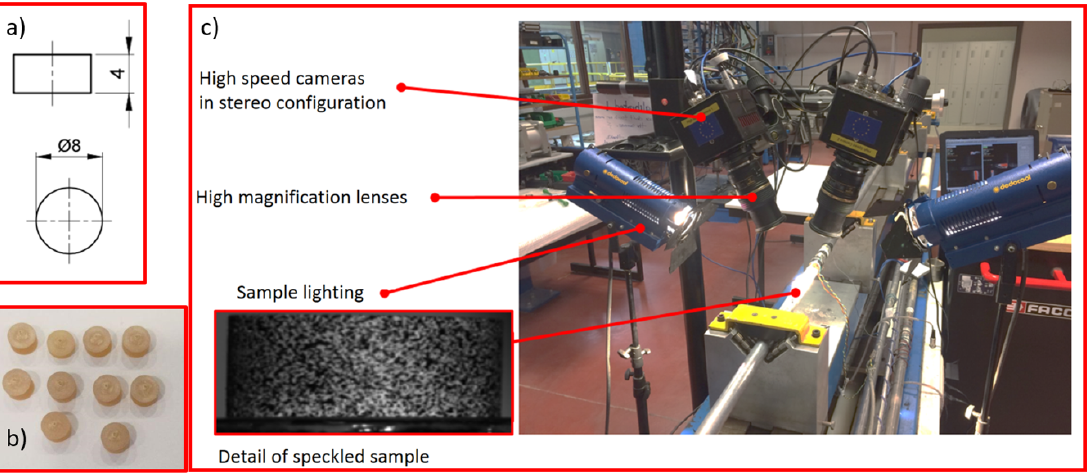
Figure 3. ( a ) Dynamic compression test sample geometry, ( b ) picture of the manufactured samples, and ( c ) detail of the split Hopkinson pressure bar setup used for the dynamic compression tests.